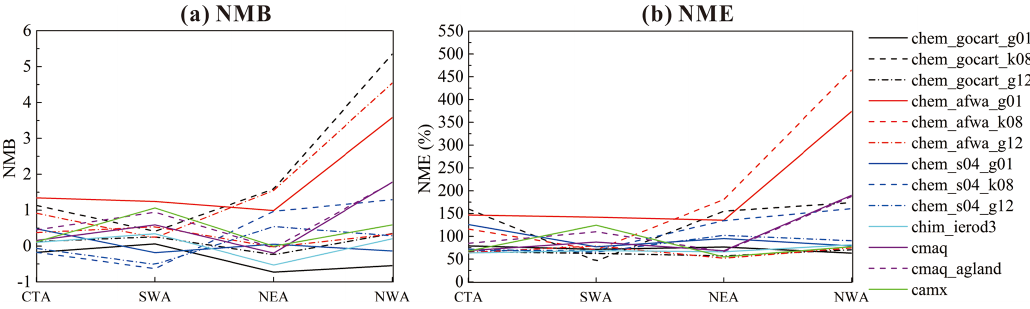
Figure 11. Normalized mean simulation bias (a) and error (b) relative to measurements of PM 10 during the dust period in the four regions of NEC shown in Fig. 2 (these are CTA, SWA, NEA, and NWA). Simulation labels follow Fig.